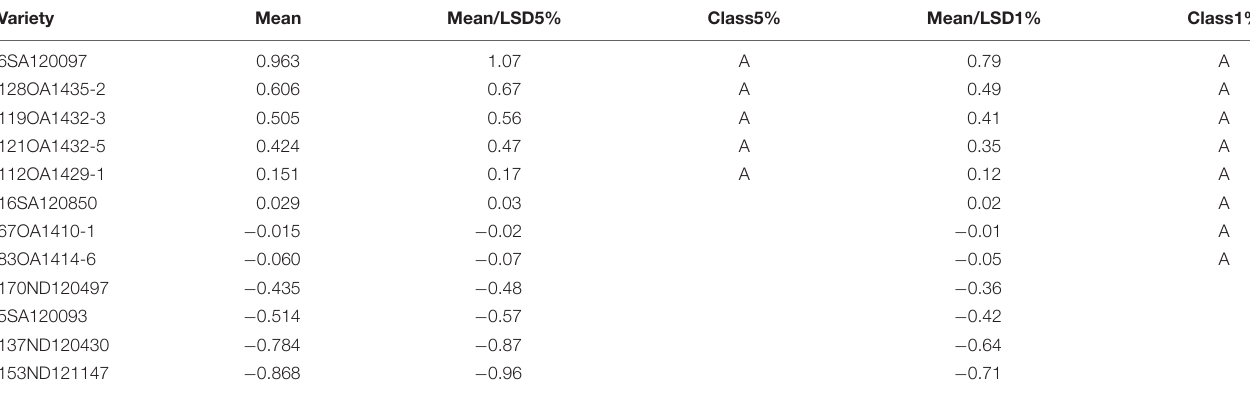
TABLE 8 | The effect of salt, alkali stresses on the chlorophyll content of tolerant and sensitive oat genotypes in experiment 3. Variety Mean